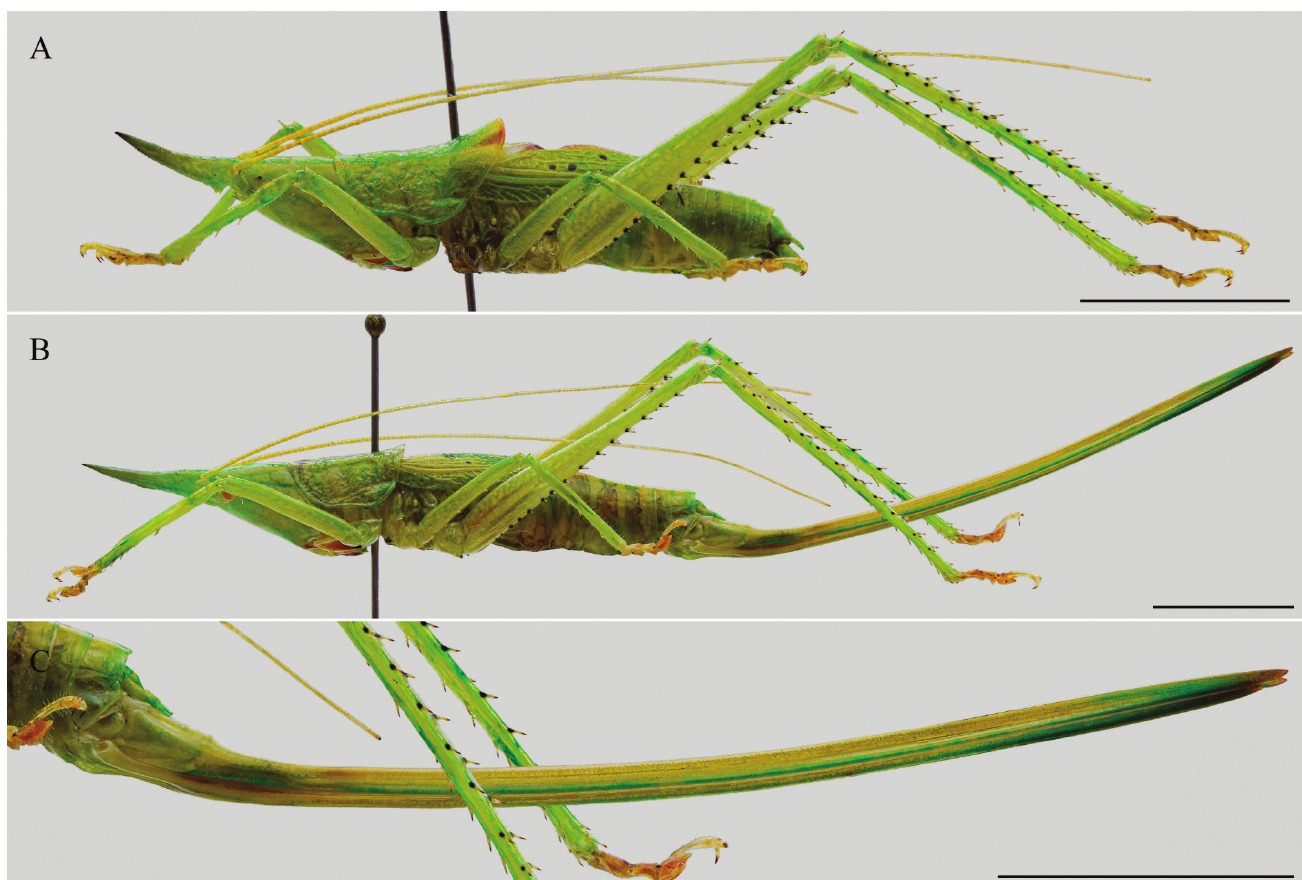
Fig. 2. Habitus of Toledopizia salesopolensis . A. Male; B. Female; C. Ovipositor. Scale bars: 1